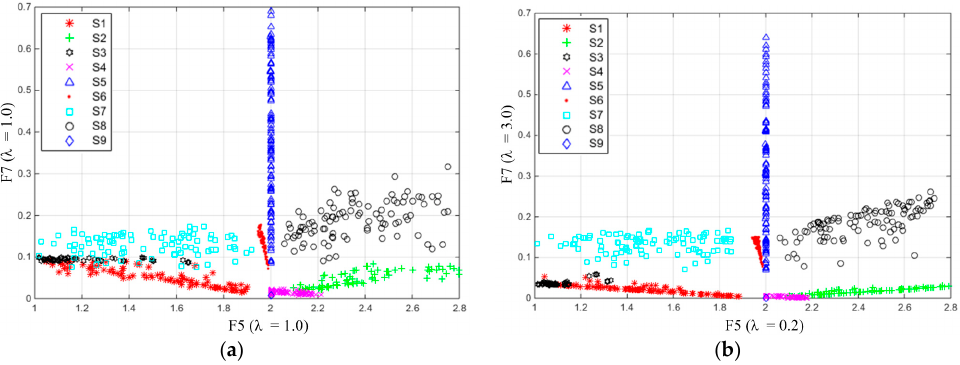
Figure 6. Comparison of F5 and F7 distribution behavior: ( a ) λ F5 = 1.0, λ F7 = 1.0; and ( b ) λ F5 = 0.2, λ F7 = 3.0.